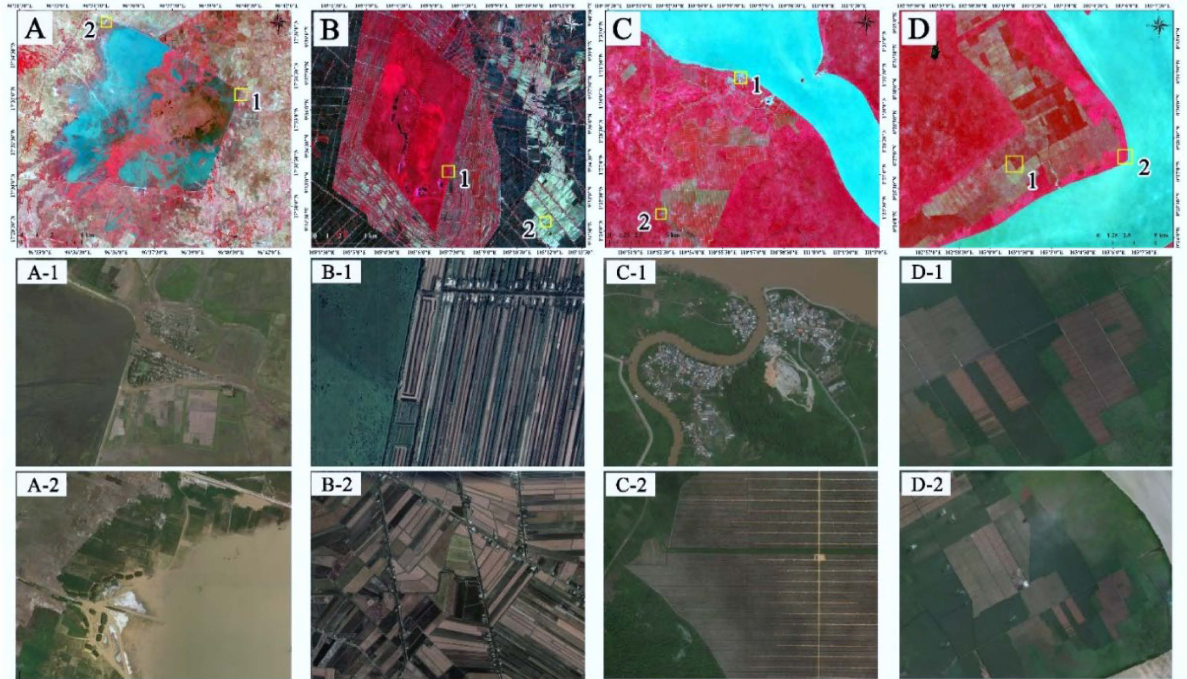
Figure 16. The expansion of human activities overlaid on the Sentinel-2 images: ( A ) Moeyungyi Wet- land Wildlife Sanctuary Ramsar (Myanmar). ( B ) U Minh Thuong National Park Ramsar site (Vietnam). ( C ) Kuching Wetlands National Park Ramsar site (Malaysia). ( D ) Kampar River Basin